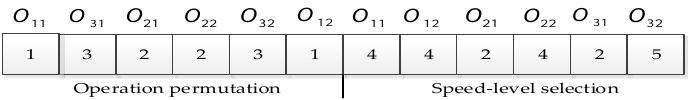
Figure 3. Individual position vector. 4.3. Conversion between Individual Position Vector and Scheduling Solution The original WOA was proposed to deal with the continuous optimization problem. However, considering the discrete characteristics of the EJSP, it is very important to find a method to establish the mapping relationship between the individual position vector and the discrete scheduling solution. In the previous study, a method is proposed to implement the conversion between the continuous individual vector and the discrete scheduling solution for the classical flexible job shop (FJSP) [39]. It is known that FJSP is made up by operation permutation and machine selection. Seen from Figure 2, the structure of the solution is similar to that of the FJSP, where the speed-level selection is taken place of the machine selection vector. Therefore, the conversion method in the literature [39] is modified for the EJSP in this study. To facilitate the expression, the intervals 1 Figure 4. The conversion process from individual position vector to operation permutation.